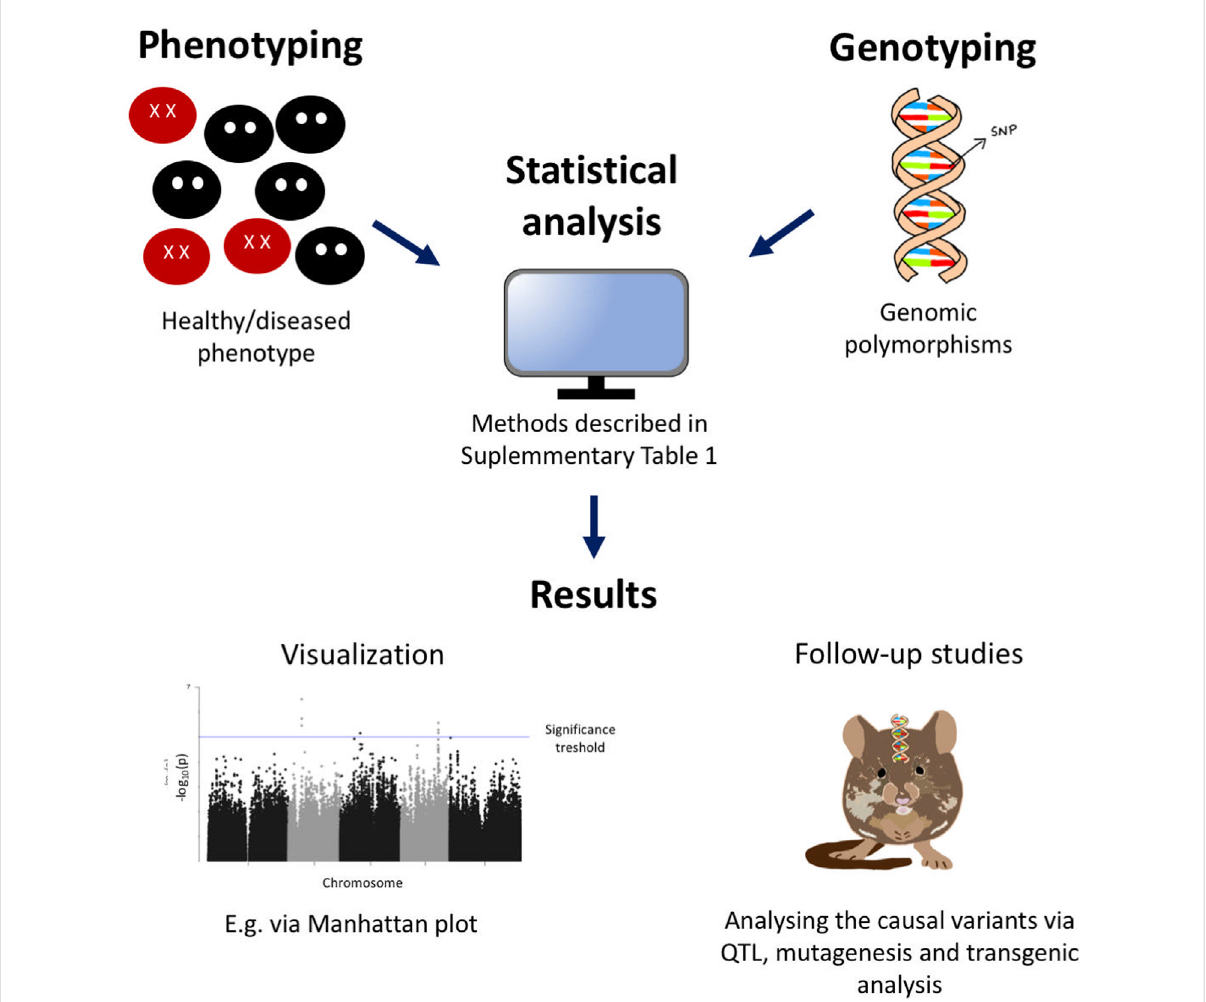
FIGURE 1 Flowchart of the steps taken in a GWAS. After phenotyping and genotyping (SNP arrays) a population of individuals with or without the trait of interest, a statistical analysis is performed and the signi fi cant SNPs correlated with the phenotype are visualized in a Manhattan plot. A signi fi cance threshold iscalculatedandalltheSNPswith − log p valuesabovethisthresholdareconsideredsigni fi cant. Thecausalvariantscanbefurtheranalyzed via follow-up studies such as, QTL, mutagenesis and transgenic